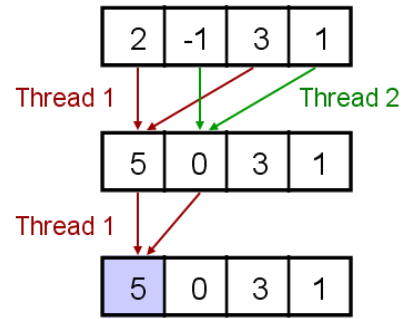
Figure 7. Simple example of parallel reduction for the summation of four